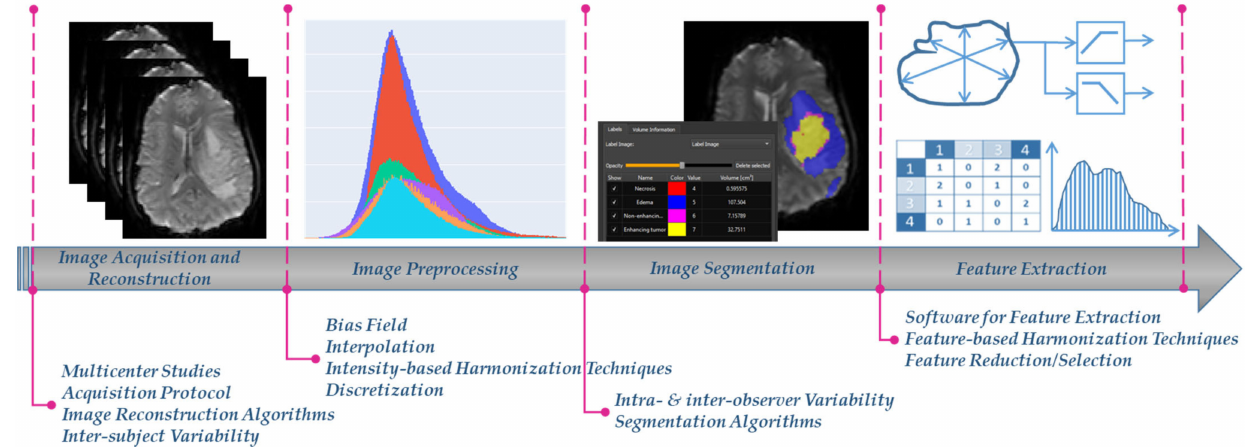
Figure 1. The radiomics analysis workflow, as partially depicted in one of our radiomics studies [5], and the different factors that affect